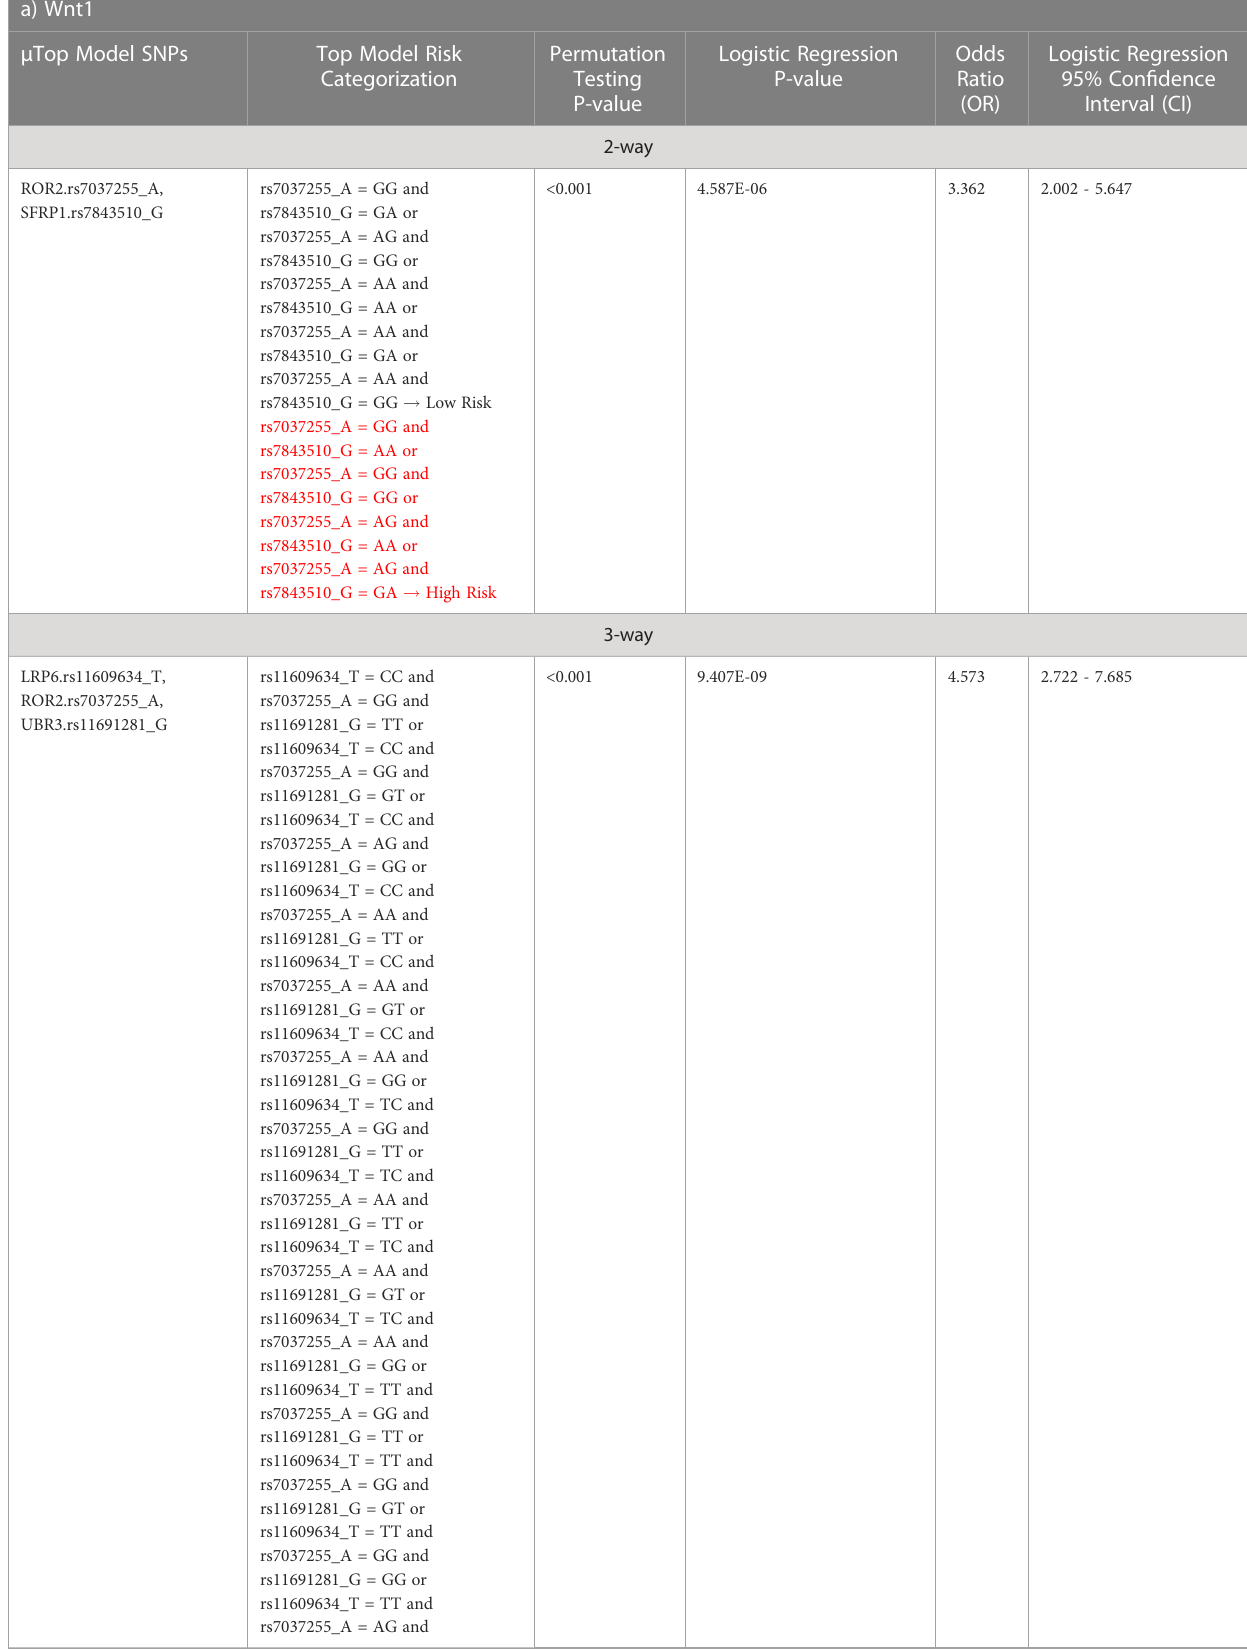
TABLE 2 Results of the two-way and three-way interaction